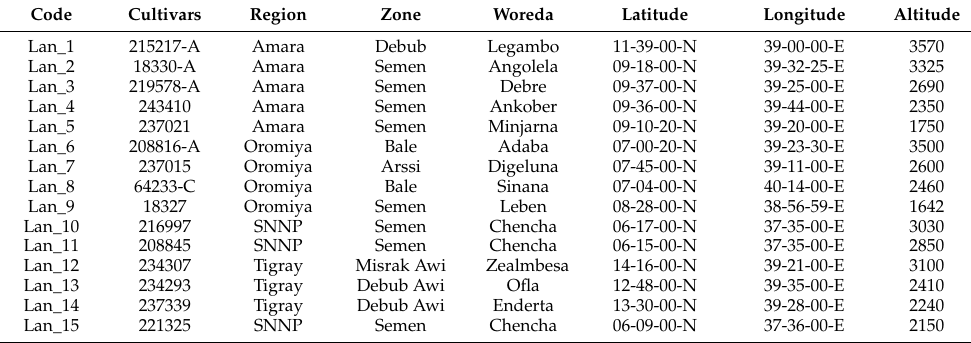
Figure A1. Map of origin of Ethiopian landrace cultivar collection. Table A1. List of Ethiopian landrace cultivars and the origin of the